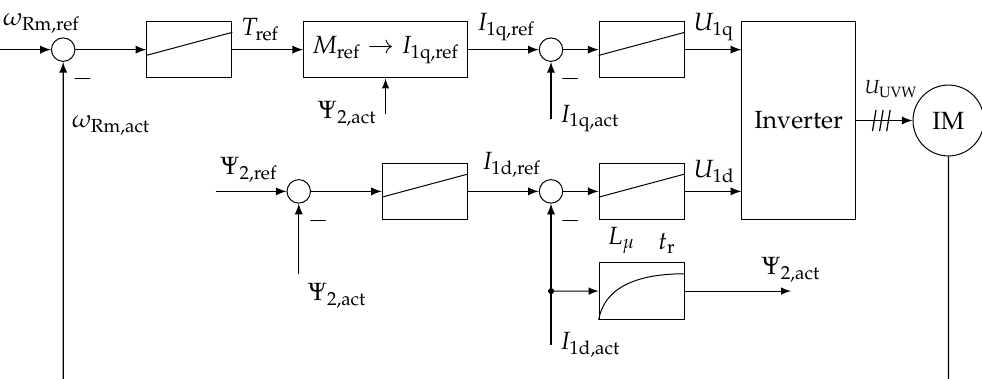
Figure 10. Control structure.